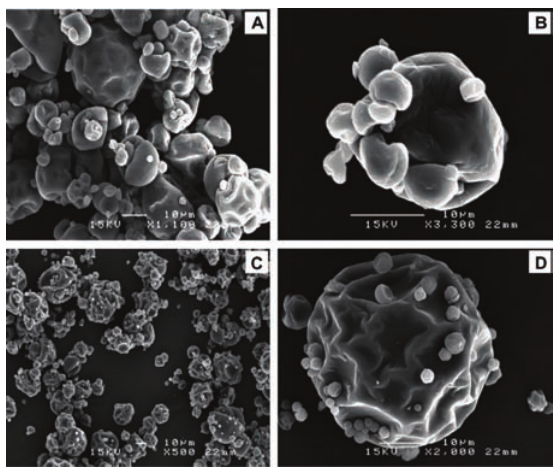
Fig. 5 Scanning electron microscope images of fish oil microcapsules spray-dried with WPC (a,b) or modified food starch (c,d) 87) .